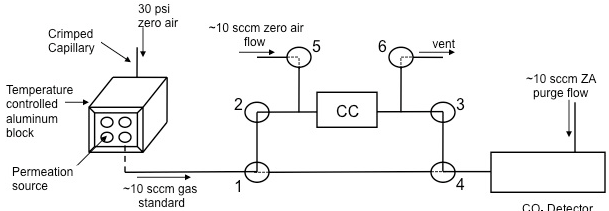
Fig. 1. A schematic diagram of the TOC calibration system. Gas standards are selectively passed over a palladium catalyst (CC). The CO 2 generated via oxidation of a standard is then measured using NDIR. During a background measurement, valves 1 and 4 open to allow flow to bypass the catalyst. At this time, valves 2 and 3 are closed shut and valves 5 and 6 are opened to flush the catalyst with zero air. To make a total carbon measurement, valves 2 and 3 opened, 5 and 6 closed, and valves 1 and 4 are switched to allow the sample to flow through the catalyst with the outflow to the CO 2 detector.